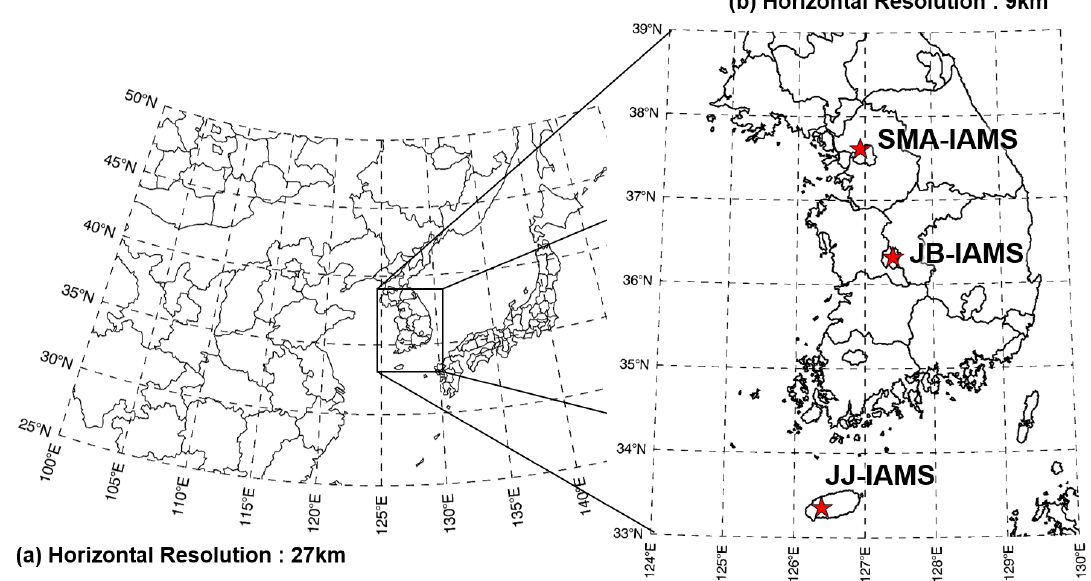
Figure 1. Spatial distribution of northeast Asia (( a ) Domain 1, 27 km) and South Korea (( b ) Domain 2, 9 km) of the CMAQ model.